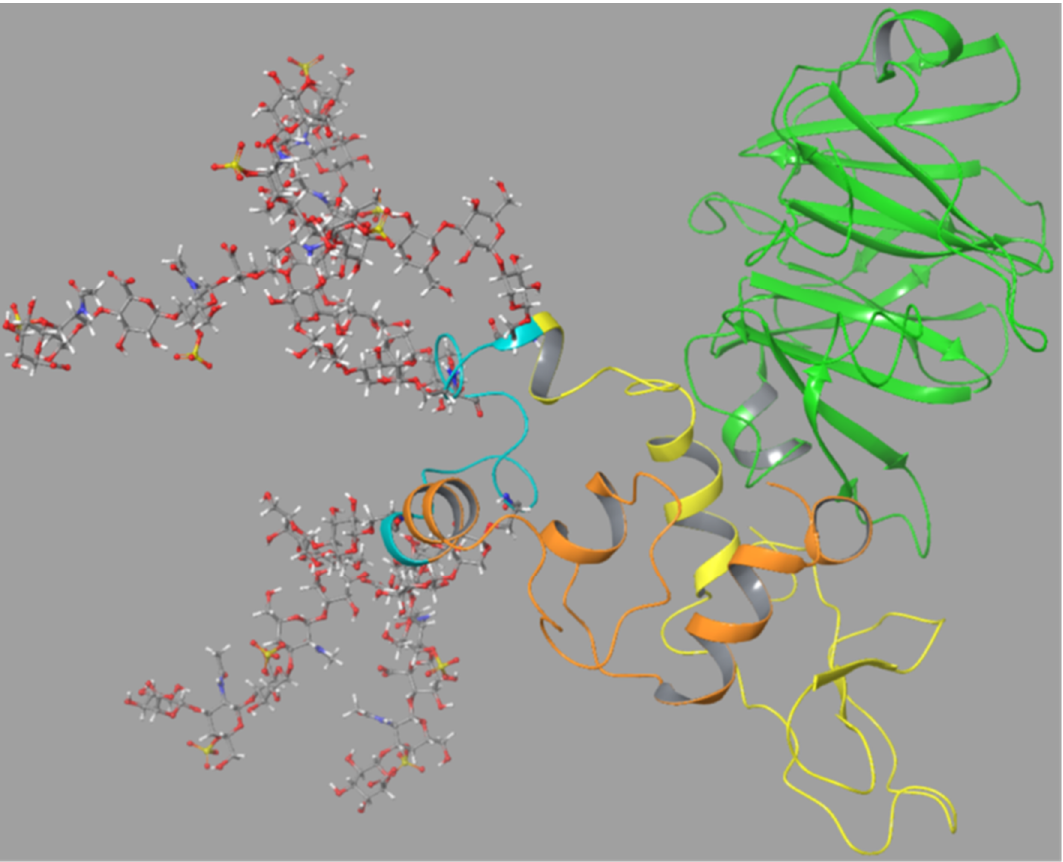
Figure 10. SG docked to the MMP-9-HPX domain, Model 1: The SG core protein was docked into the MMP-9-HPX domain using the BioLuminate program as described in the Materials and Methods. The HPX domain is labelled in light green, and the SG core protein with attached CS chains is labelled as in Figures 8 and 9. Table 2. Amino acid interactions between HPX and SG as seen in Model 1. Amino acid interactions between HPX and SG based on peptide arrays, docking, and MD simulations.